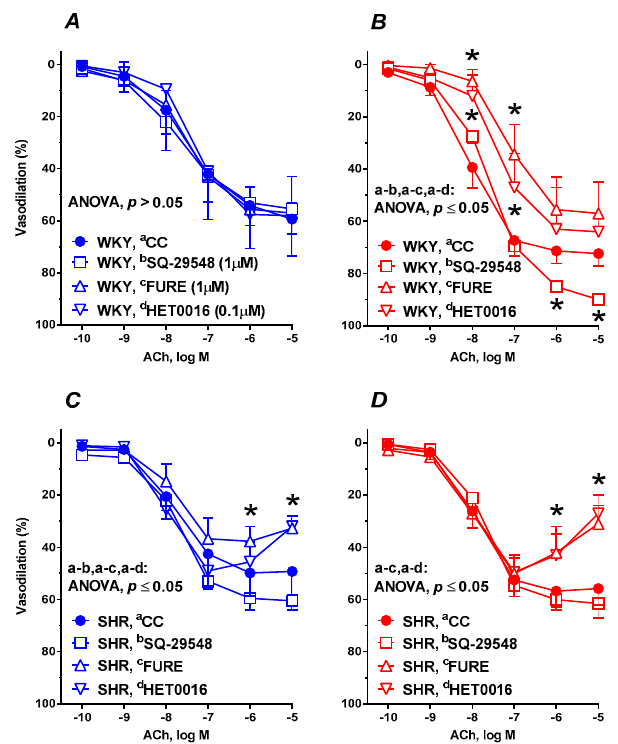
Figure 5. The influence of experimental diets on the vasodilator response to acetylcholine in thoracic arteries isolated from WKYs ( A , B ) and SHRs ( C , D ). From 10 weeks of age, rats were fed a control diet without added raspberry seeds (RBS) ( A , C ) and with a diet supplemented for 6 weeks with added 7% ground RBS ( B , D ). ACh-induced vasodilation was analyzed in the absence and presence of the thromboxane receptor (TP) antagonist (SQ-29548, 1 µ M, 30 min), TxA 2 synthesis inhibitor (furegrelate, 1 µ M, 30 min) and an inhibitor of 20-HETE formation (HET0016, 0.1 µ M, 30 min). Results (mean ± SEM) are expressed as a percentage of the inhibition of the contraction induced by noradrenaline (1.5 ± 0.18 g), * p ≤ 0.05 (two-way ANOVA/Tukey’s), m = 6–8.